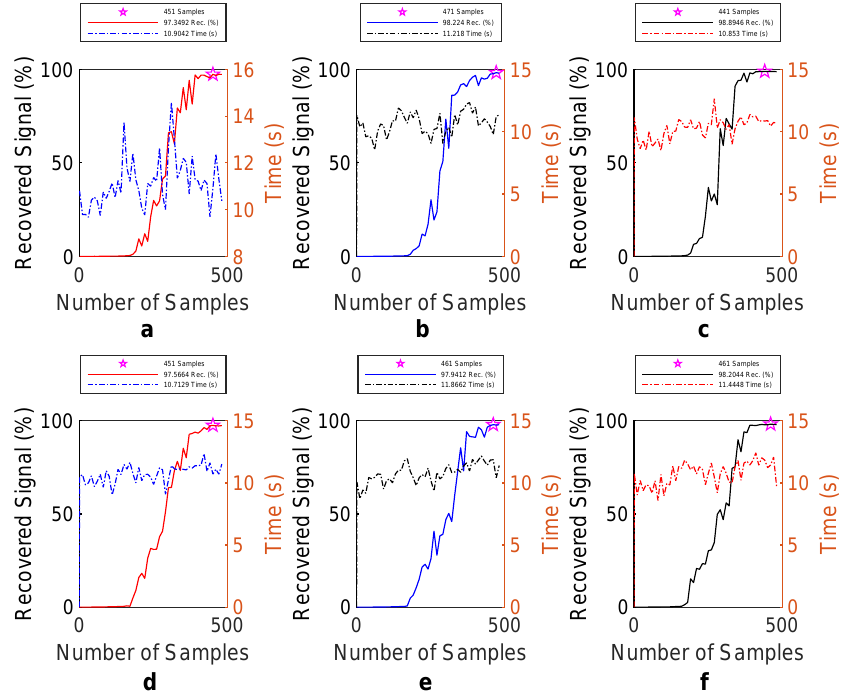
Figure 11. Number of samples m needed to recover the signal vs. processing time (( a – c ) current and ( d – f ) voltage at bus 4).